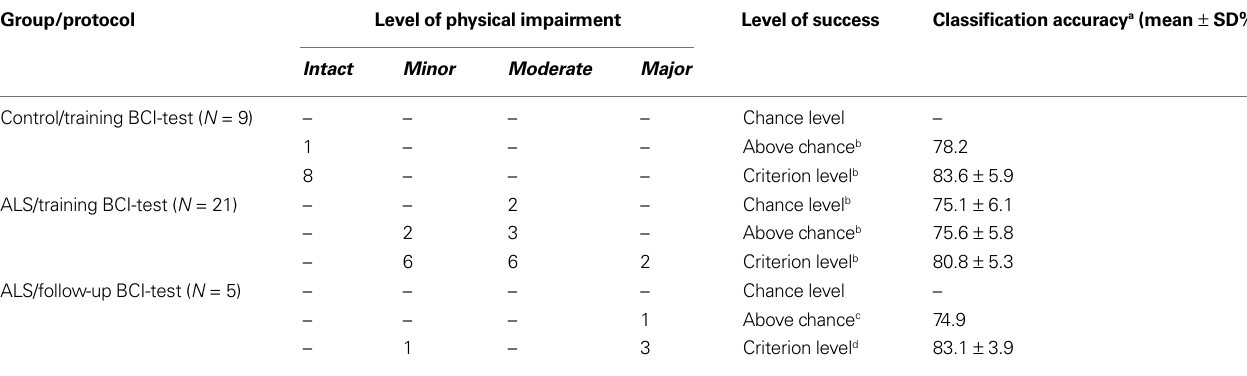
Table 9 | Overall level of success, subdivided for each category of physical impairment and for each group: chance level , above chance and criterion level